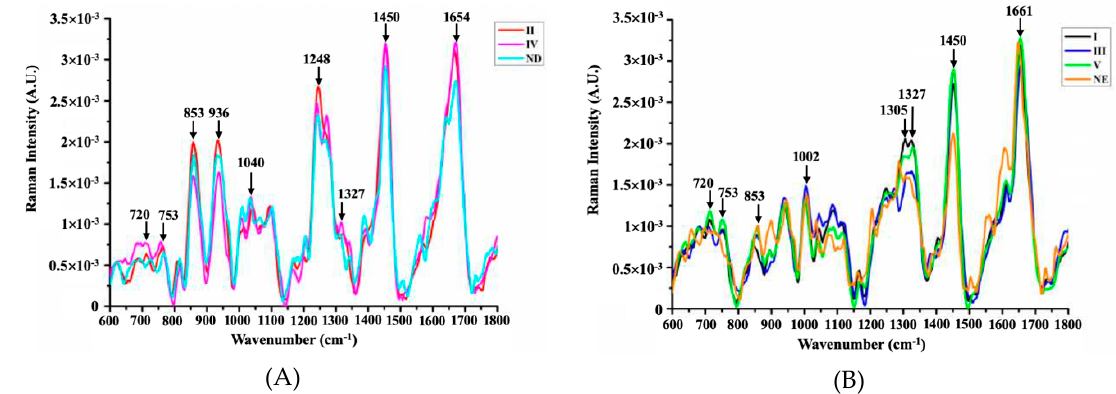
Figure 2. Comparison of Raman spectra from the II and IV regions with the normal dermis ( A ) and spectral comparison between regions I, III, IV and the normal epidermis ( B ). In that, ND is the abbreviation for normal dermis, and NE is for normal epidermis.